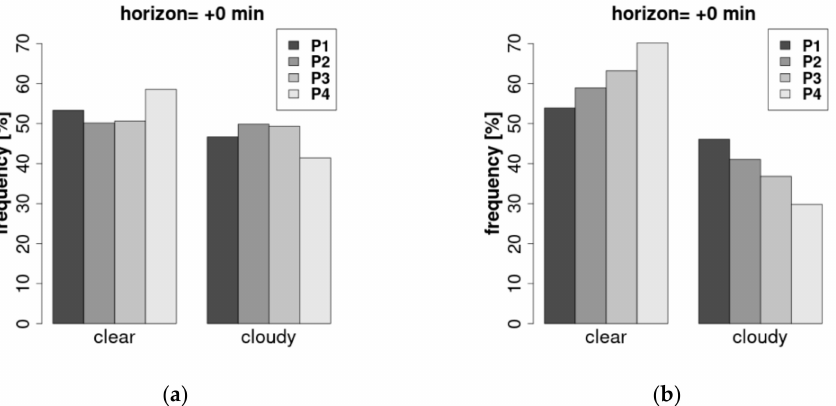
Figure A1. Bar plots regarding the amount of clear and cloudy sky conditions at the starting time for the four PV plants. In ( a ) the fraction of clear and cloudy conditions using the central MSG point, in ( b ) the corresponding values obtained using the mode value over a box 3 × 3